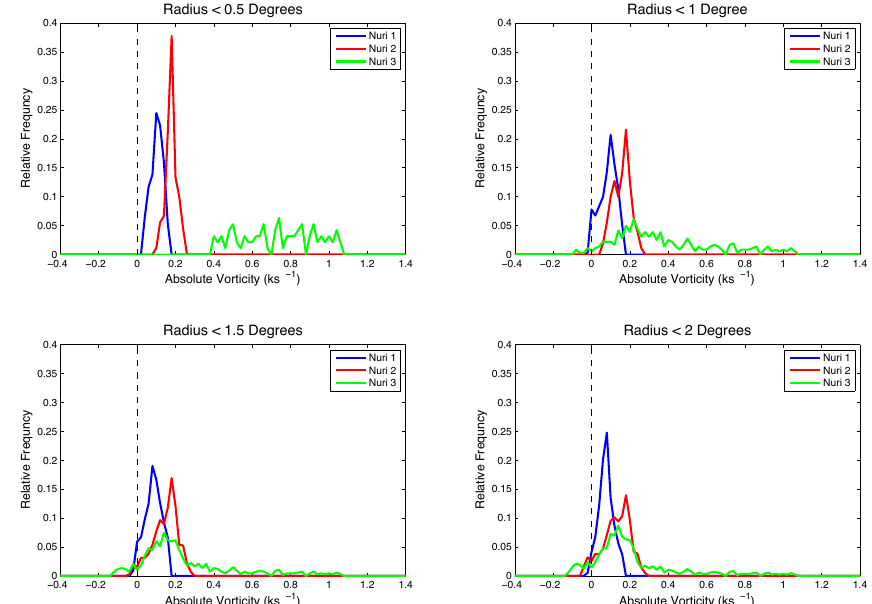
Figure 9. Four-panel plot of relative frequency of absolute vorticity for Nuri 1 (blue), Nuri 2 (red), and Nuri 3 (green) derived from the 10km SAMURAI analyses. The relative frequency distributions are calculated in 0.5 degree radius intervals from the 1.5km altitude sweet spot position out to two degrees. The dashed black line represents the zero absolute vorticity value.